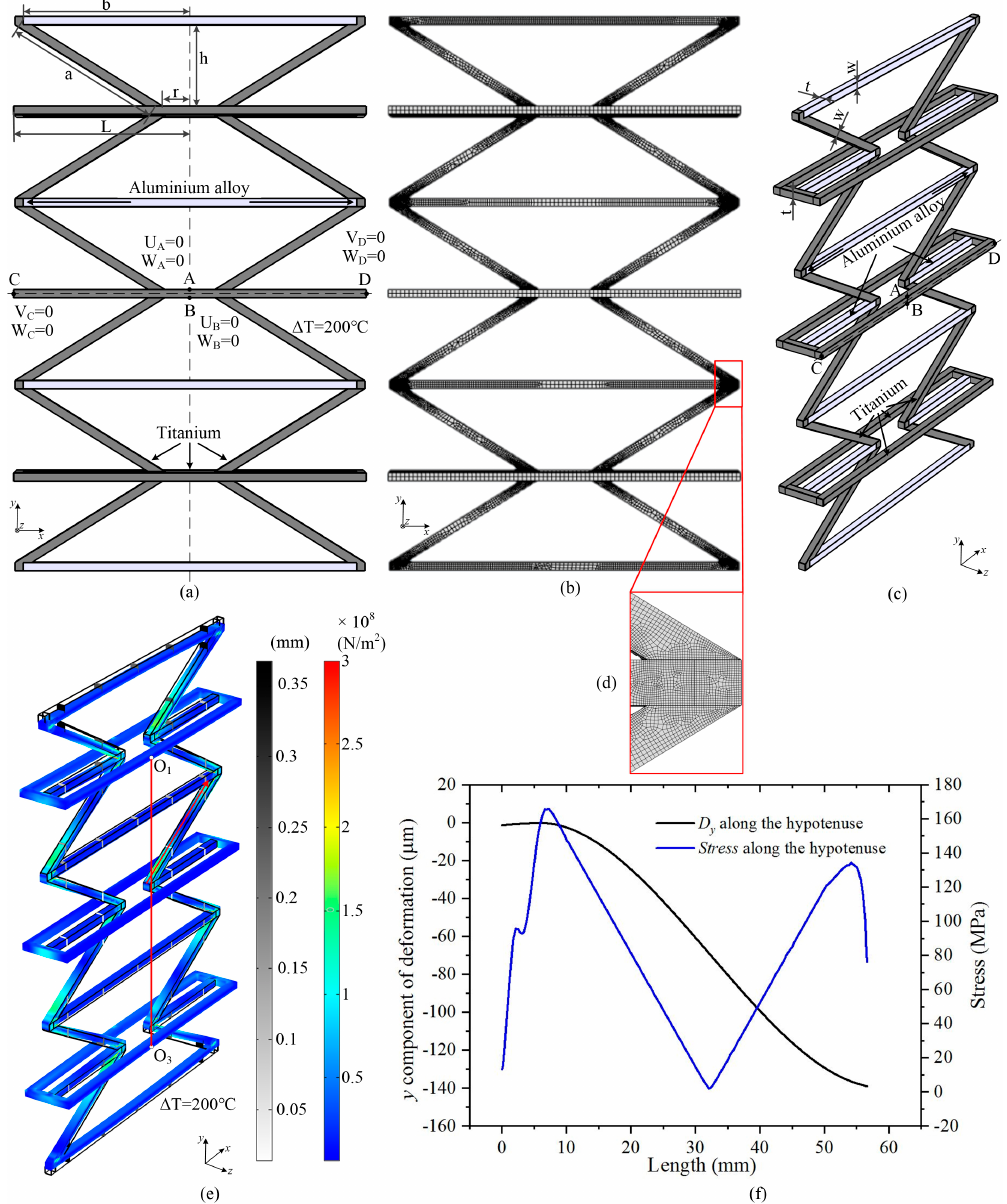
Figure 4. Geometrical model of the numerical simulation. ( a ) Front view of the geometrical model used in the numerical simulation and the boundary conditions in the model. ( b ) Finite element mesh of the ITL array. The members are meshed by hexahedral elements. ( c ) A 3D view of the geometrical model. ( d ) Finite element mesh of interface between the two constituents. ( e ) The deformation and stress of an ITL array (r = 24 mm, b = 60 mm, h = is 30 mm, L / r = 5, α a = 8.6 × 10 − 6 K − 1 , α a = 23 × 10 − 6 K − 1 , t = w = 5 mm) induced by a temperature increase of 200 °C. The legend bars indicate overall deformation and stress distribution, respectively. The vertical red line is the center distance of the long rods on the first and third X-symmetric ITL. ( f ) The y component of deformation and stress along the hypotenuse. It is plotted according to the simulation results of the tilted red line in Figure 4 ( e